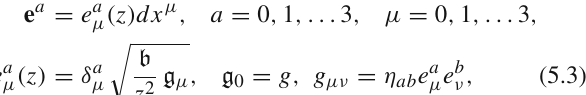
potential μ and c B = 0 ( D ), c B = − 0 . 001 ( E ) and c B = − 0 . 005 ( F ). Here ν = 4 . 5. The dashed lines represent values of σ 11 calculated in thermodynamically unstable